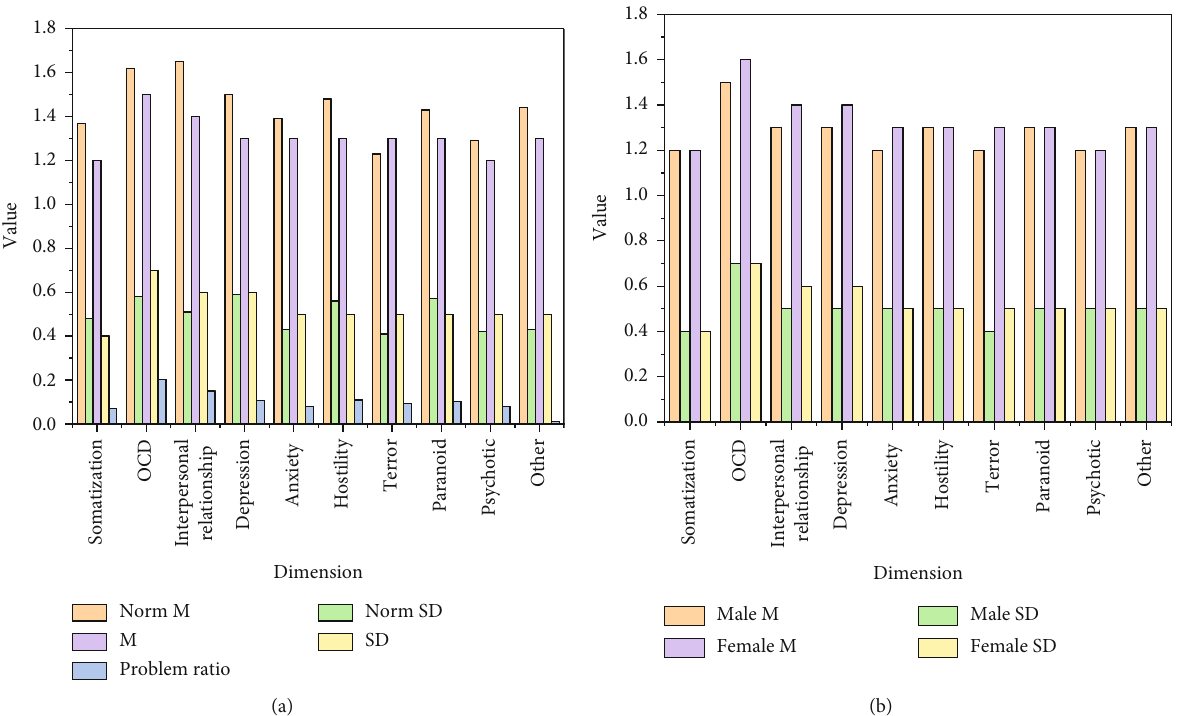
0.00.20.40.60.81.01.21.41.61.8